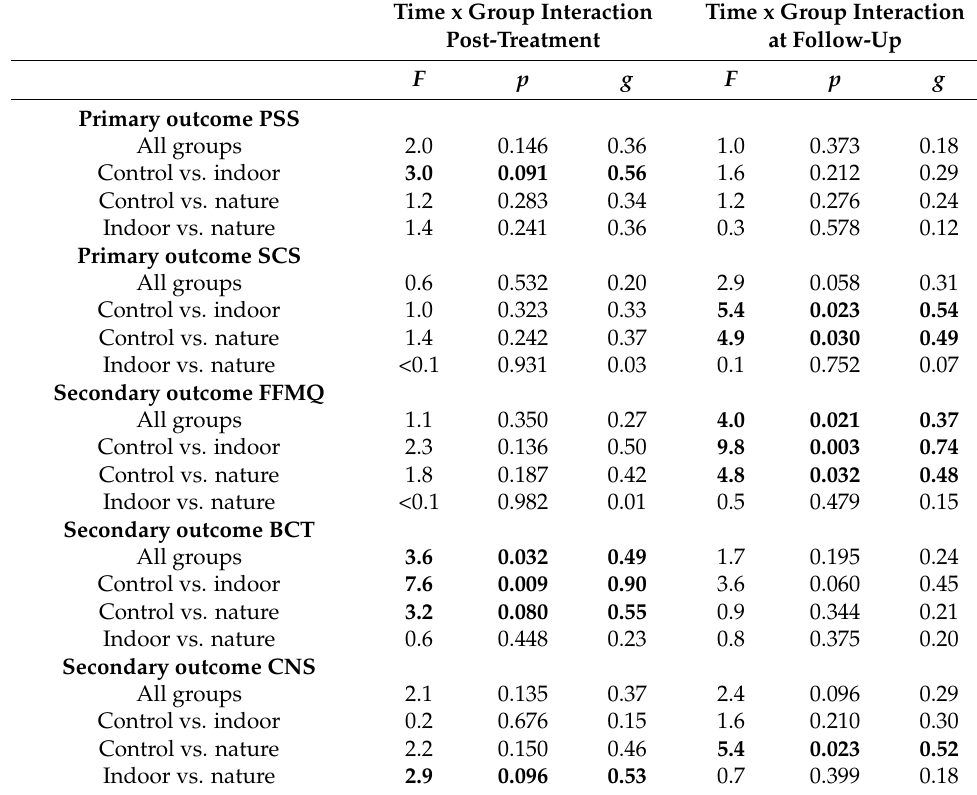
Table 4. Results from multilevel interaction